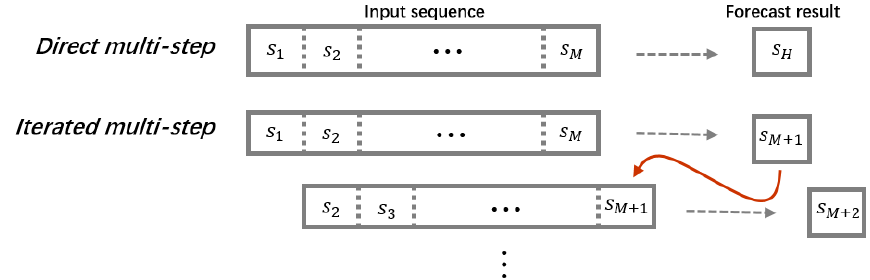
Figure 4. Two common ways in sequence prediction for ENSO forecasts: direct multi-step (DMS) and iterated multi-step (IMS).